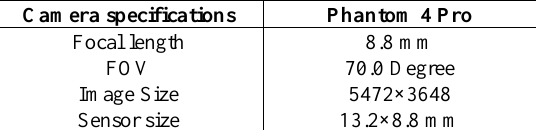
Table 1 . Specifications for drone cameras.